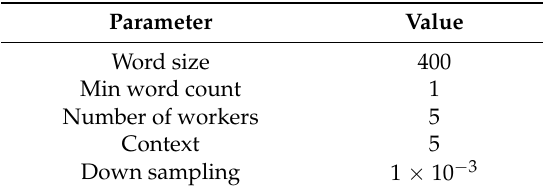
Table 3. Word2vec model tuned